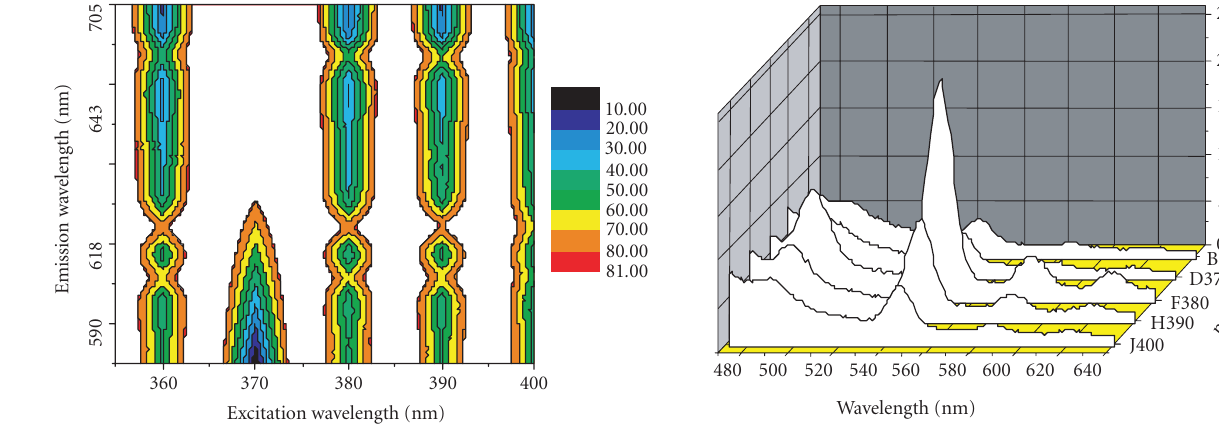
Figure 12: 3D view of the emission spectra of Tb 3+ ion in MC-Tb complex at di ff erent excitation wavelengths in DMSO.